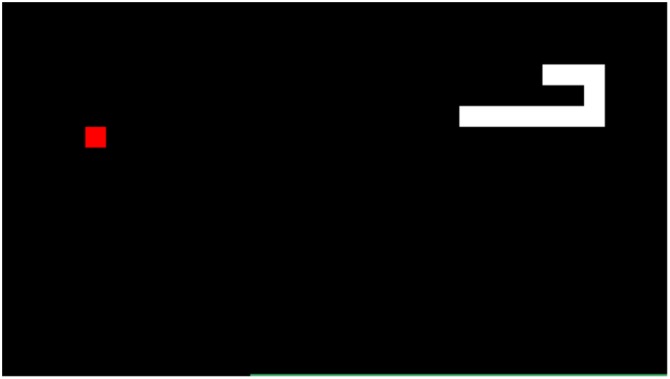
The Snake game which supports training of spatial orientation in a 2D virtual environment.